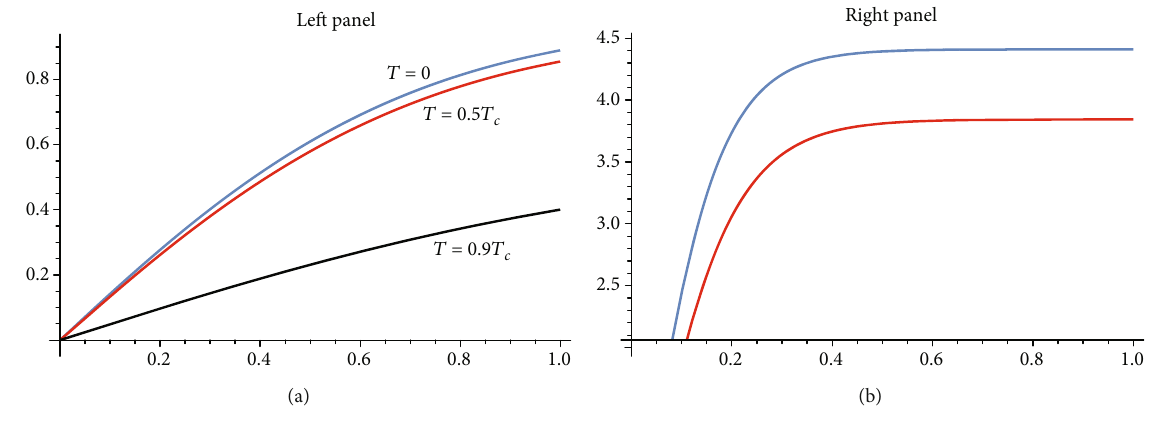
Figure 2: A graph of net con fi ning potential, V